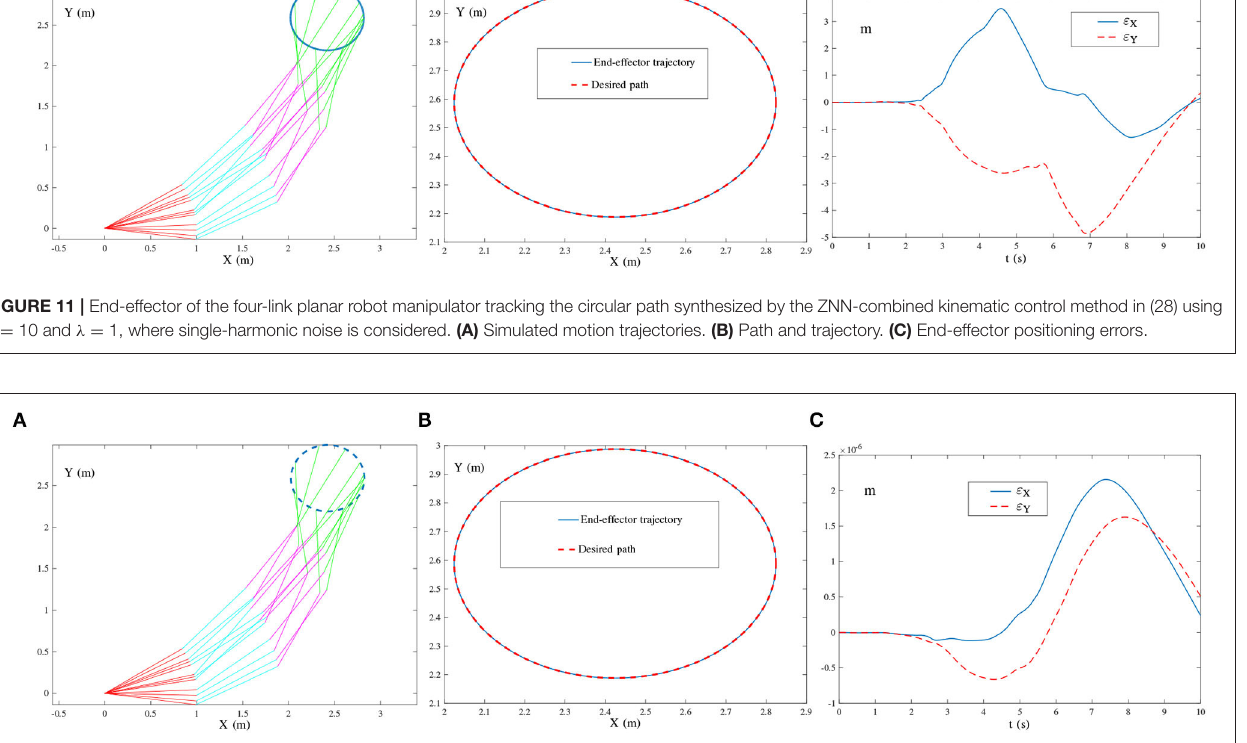
FIGURE 12 | End-effector of the four-link planar robot manipulator tracking the circular path synthesized by the ZNN-combined kinematic control method in (28) using τ = 10 and λ = 1, where multiple-harmonic noise is considered. (A) Simulated motion trajectories. (B) Path and trajectory. (C) End-effector positioning errors.